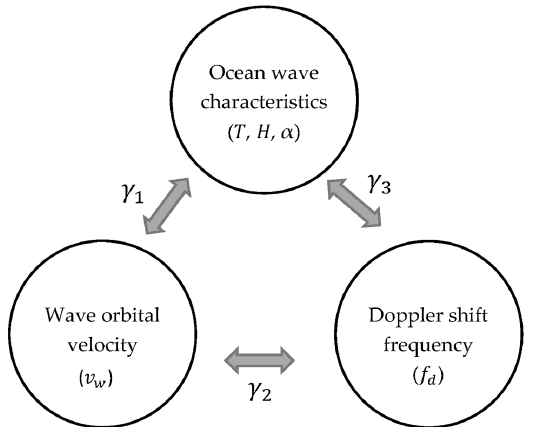
Figure 1. Relationships between wave orbital velocity, ocean wave characteristics, and Doppler shift frequency. The wave measurement starts from measuring Doppler shift frequency with the radar. The variation of the measured Doppler shift frequency contains the information of the wave period, height, and direction. It is explained with the relationship γ 3 , which is deduced from γ 1 and γ 2